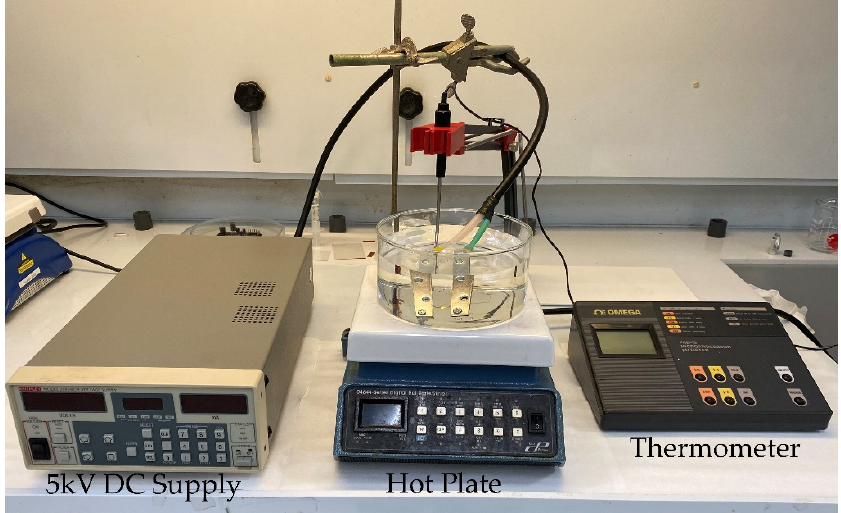
Figure 1. Thermal poling apparatus.